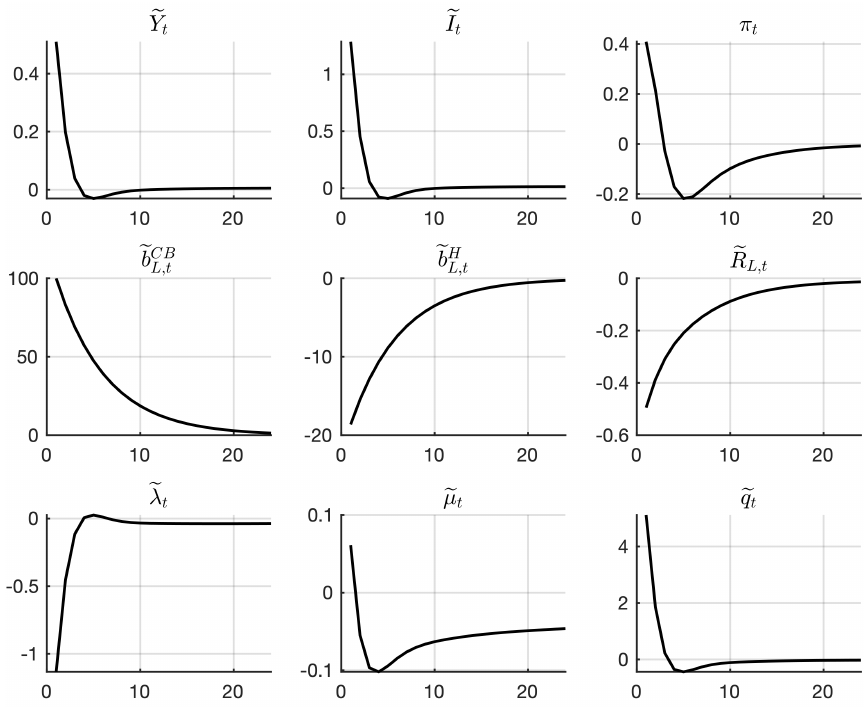
Figure 1. Baseline simulation for BoJ’s